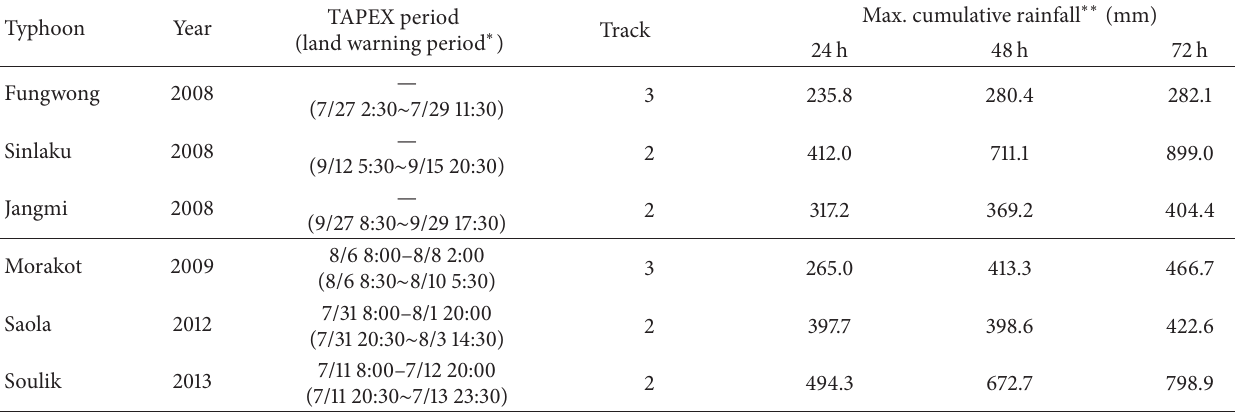
Figure 3: Flow chart of this study in terms of data processing and performance evaluation. Table 1: Collected six typhoons’ historical data. The first three typhoons’ observed data, namely, Typhoon Fungwong, Typhoon Sinlaku, and Typhoon Jangmi, were used for model calibration and validation. The second three typhoons’ TAPEX ensemble quantitative precipitation forecasts, namely, Typhoon Morakot, Typhoon Saola, and Typhoon Soulik, were used for model application to provide the reservoir inflow forecast for the Shihmen